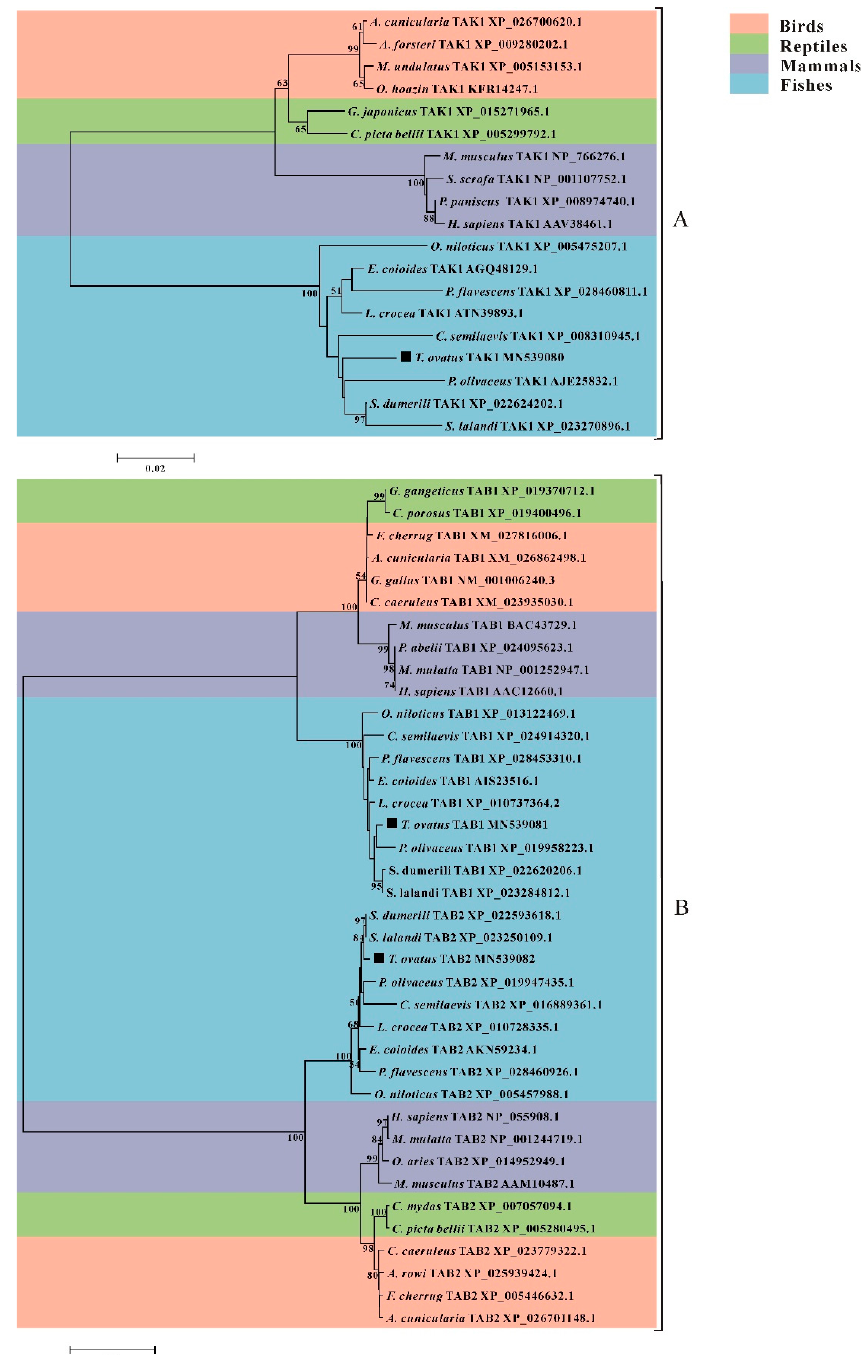
Figure 7. Evolutionary relationships of the TAK1 ( A ), TAB1 and TAB2 ( B ) of vertebrates. The tree was inferred using the neighbor-joining method with bootstrap settings of 10,000 replicates. The trTAK1, trTAB1 and trTAB2 analyzed in the study are marked by black boxes. The evolutionary distances were computed using the JTT matrix-based method. The analysis of A and B involved 19 and 38 amino acid sequences, separately. The sequences used for phylogenetic analysis of TAK1 and/or TAB1 and/or TAB2 in different species, including T. ovatus, S. dumerili, E. coioides, L. crocea, P.